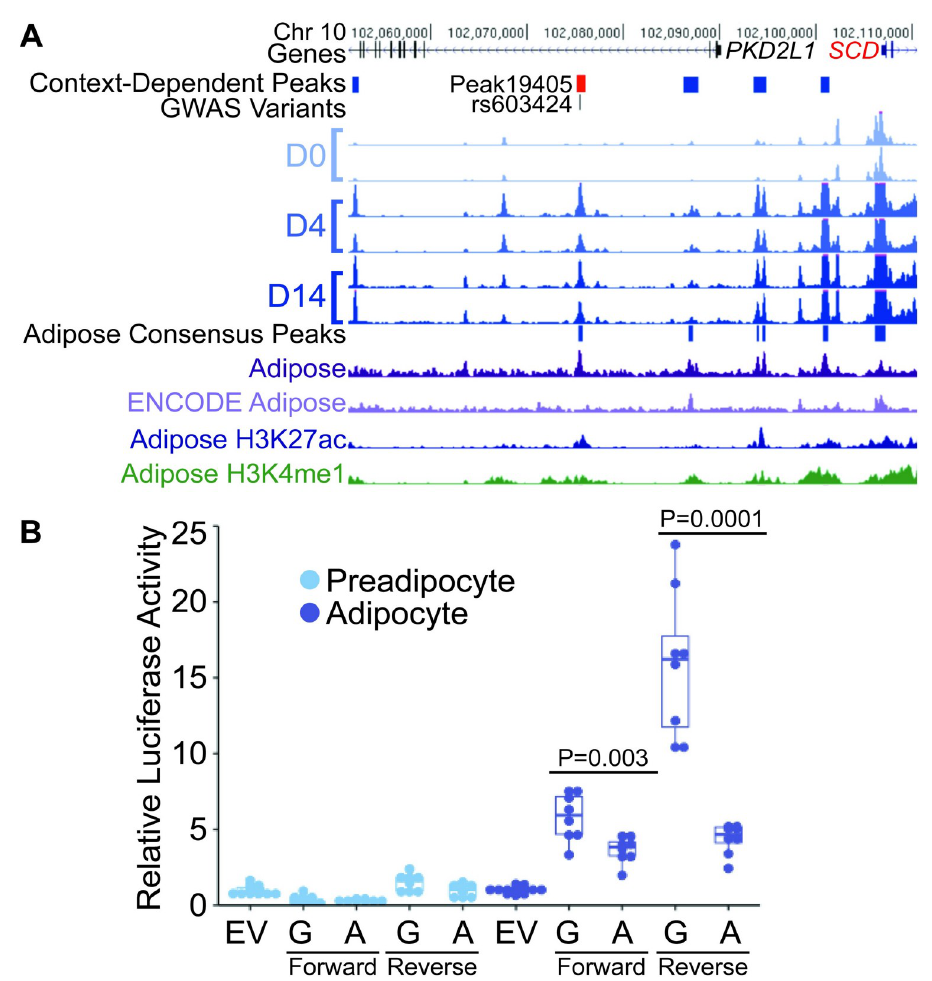
Fig 4. Allelic differences in transcriptional activity for a context-dependent regulatory variant in a context- dependent element at the SCD locus. (A) Peak19405 (red) is more accessible in D4 and D14 adipocytes than D0 preadipocytes, overlaps an adipose tissue consensus peak (dark purple), and overlaps variant rs603424, which is associated with blood plasma levels of palmitoleic acid and adipose SCD expression. SCD is also more highly expressed at D4 and D14 compared to D0. Additional tracks show adipose tissue ATAC-seq from ENCODE (light purple) and adipose nuclei histone mark ChIP-seq from the Roadmap Epigenomics project (blue and green). (B) A 592-bp genomic region surrounding peak19405 containing the rs603424-G allele shows increased transcriptional activity compared to the rs603424-A allele in the forward and reverse orientations only in adipocytes (tested at day 12), the context in which chromatin was more accessible compared to preadipocytes. Dots represent two independent constructs assayed from four replicates each. Luciferase activity was normalized relative to an empty vector (EV). Values in S18